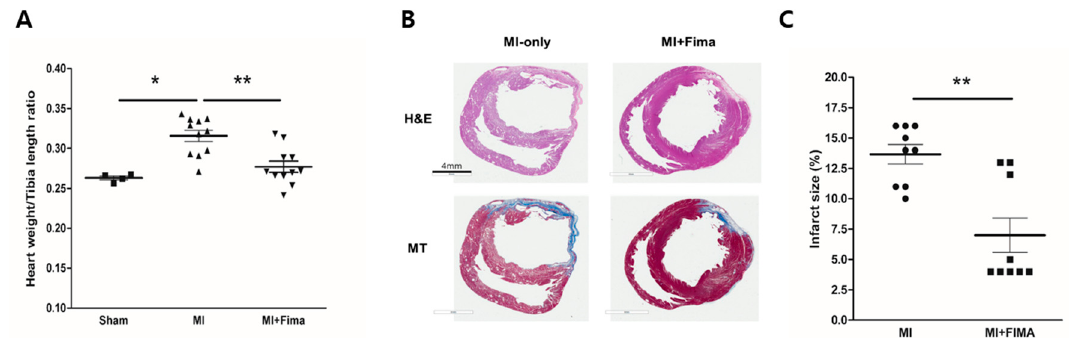
Figure 3. A histologic examination of the explanted hearts: ( A ) Cardiac hypertrophy was assessed as the heart weight/tibia length ratio. Fimasartan attenuated the induction of cardiac hypertrophy after MI. ■ , sham; ▲ , MI; ▼ , MI + Fima. ( B ) The hematoxylin and eosin (H&E) and Masson trichrome (MT) staining showed a smaller infarct size and fibrosis in the MI + Fima group. ( C ) The MI + Fima group ( ■ ) had a smaller infarct size than the MI-only group ( ● ). The P -values represent * P < 0.05, and ** P < 0.01. The results are expressed as mean ± SEM.